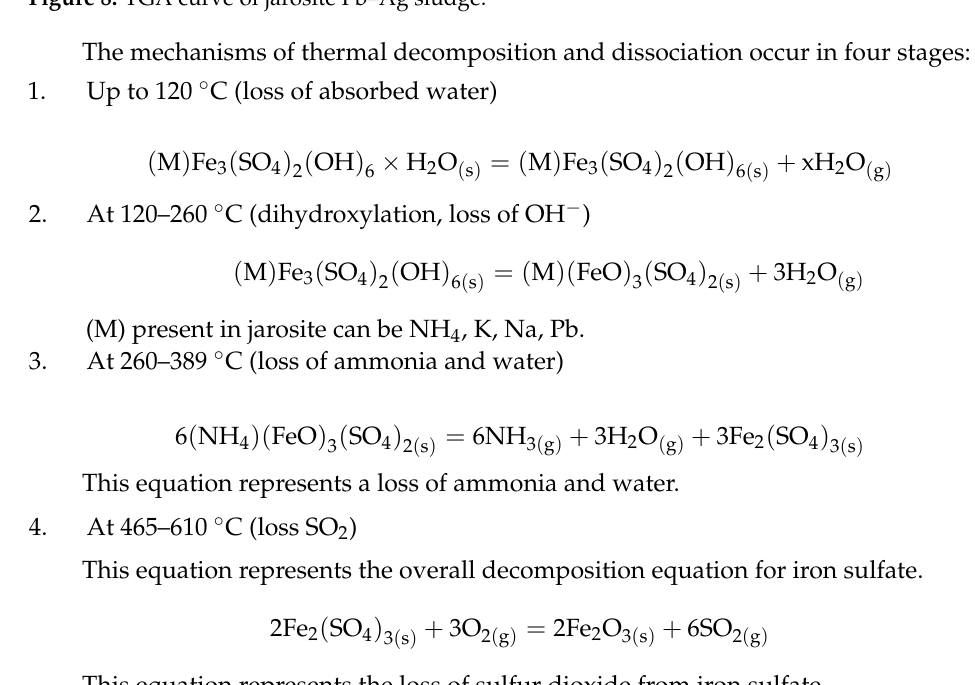
Figure 8. TGA curve of jarosite Pb–Ag sludge.